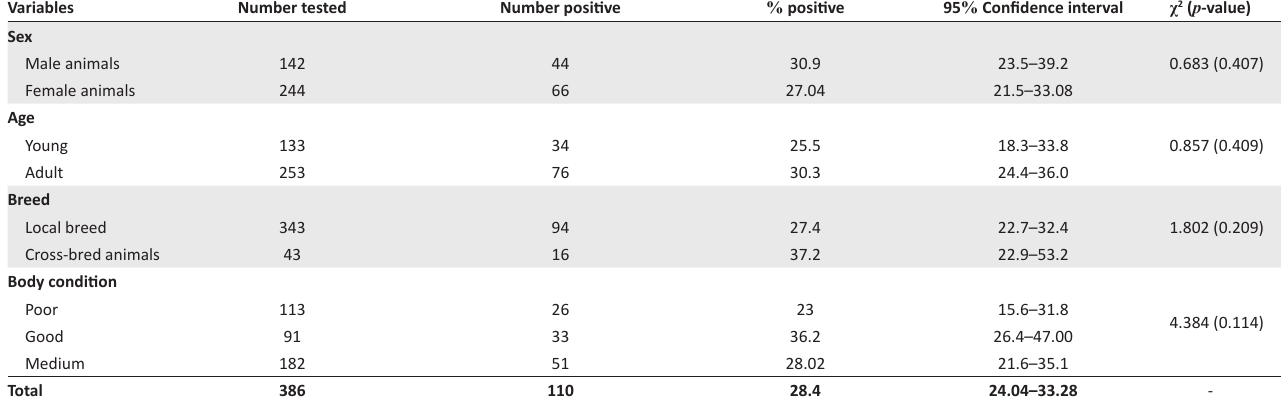
TABLE 3: Seroprevalence of contagious bovine pleuropneumonia measured against different host-related risk factors.